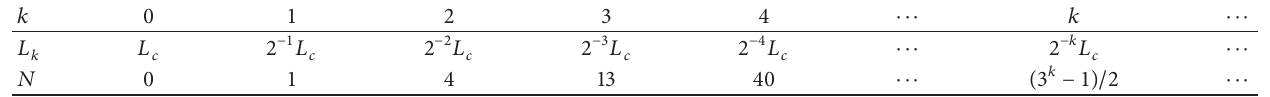
Table 1: The void distribution of Sierpinski gasket.